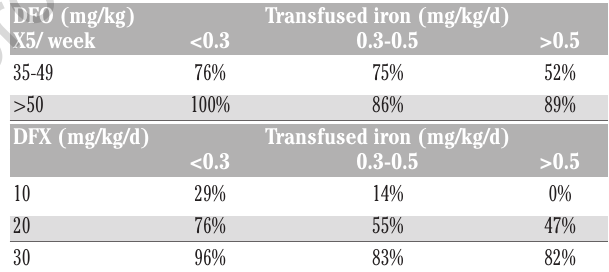
Table 2. Percentage of patients achieving negative iron balance based on transfusional iron loading rate and chelator dose (Data from Cohen A, et al. Blood 2008; 111:583-7).